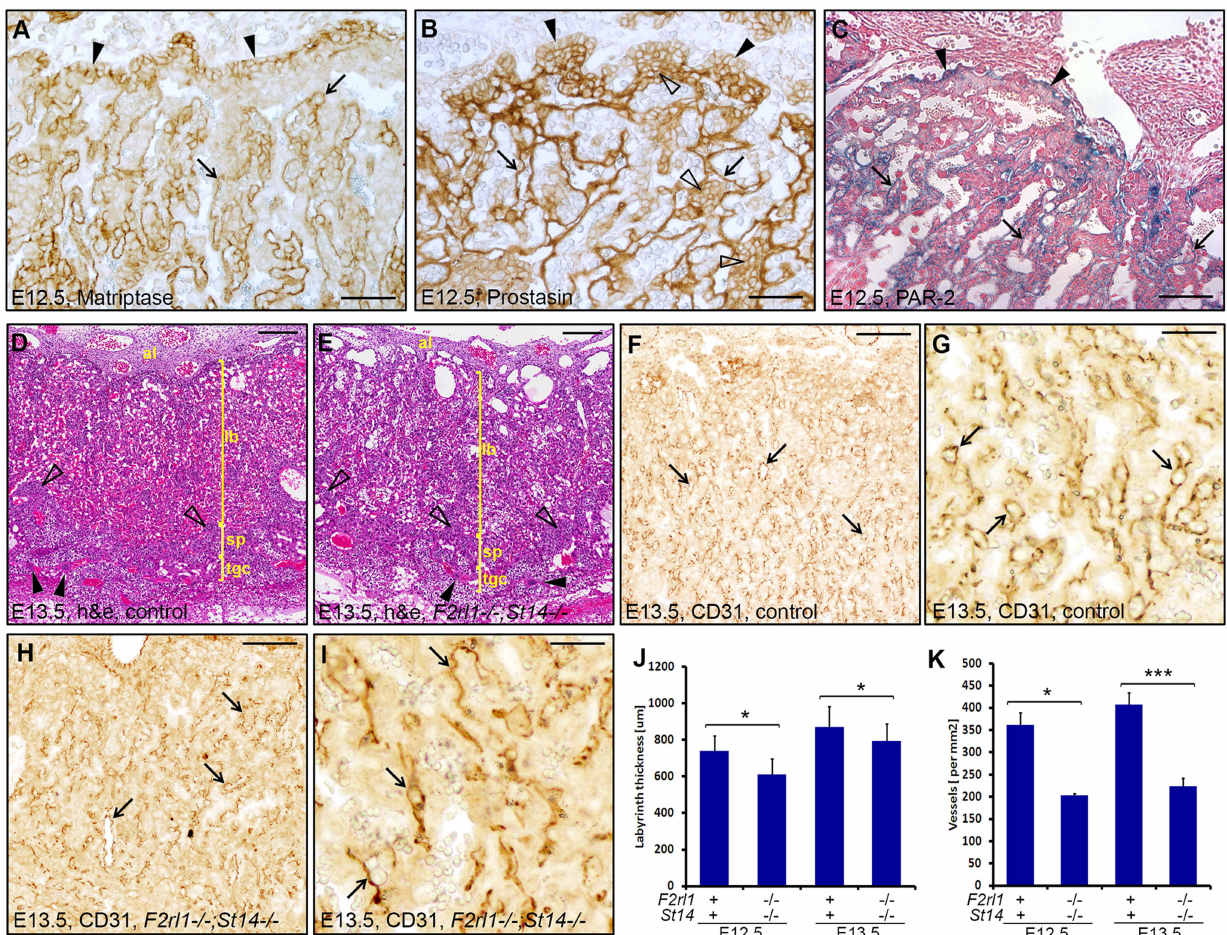
Figure 3. A combined loss of PAR-2 and matriptase leads to underdevelopment of placental labyrinth. ( A, B ). Immunohistochemical detection of matriptase ( A ) and prostasin ( B ) in mouse placenta at E12.5. Expression of both proteins was observed in chorionic epithelium ( A and B , arrowheads) and in the differentiated syncytiothrophoblast layer of the labyrinth ( A and B , arrows). Prostasin, but not matriptase, was also detected in the mononuclear cytotrophoblast cells within the labyrinth ( B , open arrowheads). ( C ). Histological analysis of PAR-2 expression in the developing placenta from E12.5 F2rl1- b gal knock-in embryos. Beta-galactosidase reporter activity was detected both in chorionic epithelium (arrowheads) and in the syncytiothrophoblast layer surrounding fetal vessels within the labyrinth (arrows). ( D, E ). Histological evaluation of the placental development in control ( D ) and F2rl1 2 / 2 ;St14 2 / 2 ( E ) animals at E13.5. H&E staining confirmed the presence of all major structural components of the mouse placenta, including allantoic mesenchyme (al), placental labyrinth (lb), spongiotrophoblast layer (sp, examples with open arrowheads), and trophoblast giant cells (tgc, examples with arrowheads), in the double-deficient embryos ( F–I ). Immunohistochemical visualization of fetal vasculature in the E13.5 placentas. Low ( F, H ) and high ( G, I ) magnification images of the staining for the endothelial cell marker PECAM-1/CD31 in the placentas of the control ( F, G ) and F2rl1 2 / 2 ;St14 2 / 2 ( H,I ) mice shows presence of the branched fetal vascular tree ( F–I , arrows) within the placental labyrinth of the PAR-2/matriptase double-deficient animals, although the apparent vascular density is lower than in the wildtype littermate control tissues. ( J, K ). Quantification of the thickness of the placental labyrinth ( J ) and the number of fetal vessels ( K ) within the labyrinth of control ( F2rl1 + ;St14 + ) and F2rl1 2 / 2 ;St14 2 / 2 E12.5 and E13.5 placentas. The measurements show decreased thickness and vascularization of the labyrinth layer in F2rl1 2 / 2 ;St14 2 / 2 placentas at E12.5 and E13.5. P values: * , 0.05, ** , 0.01, *** , 0.001, Student’s t-test, two-tailed. Scale bars: ( A, B ) 50 m m, ( C ) 100 um, ( D, E, F, H ) 200 m m, ( G, I ) 50 m